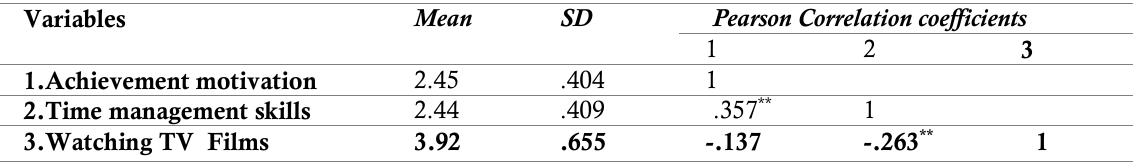
Table 4. The Correlation Watching TV films, Time Management Skills